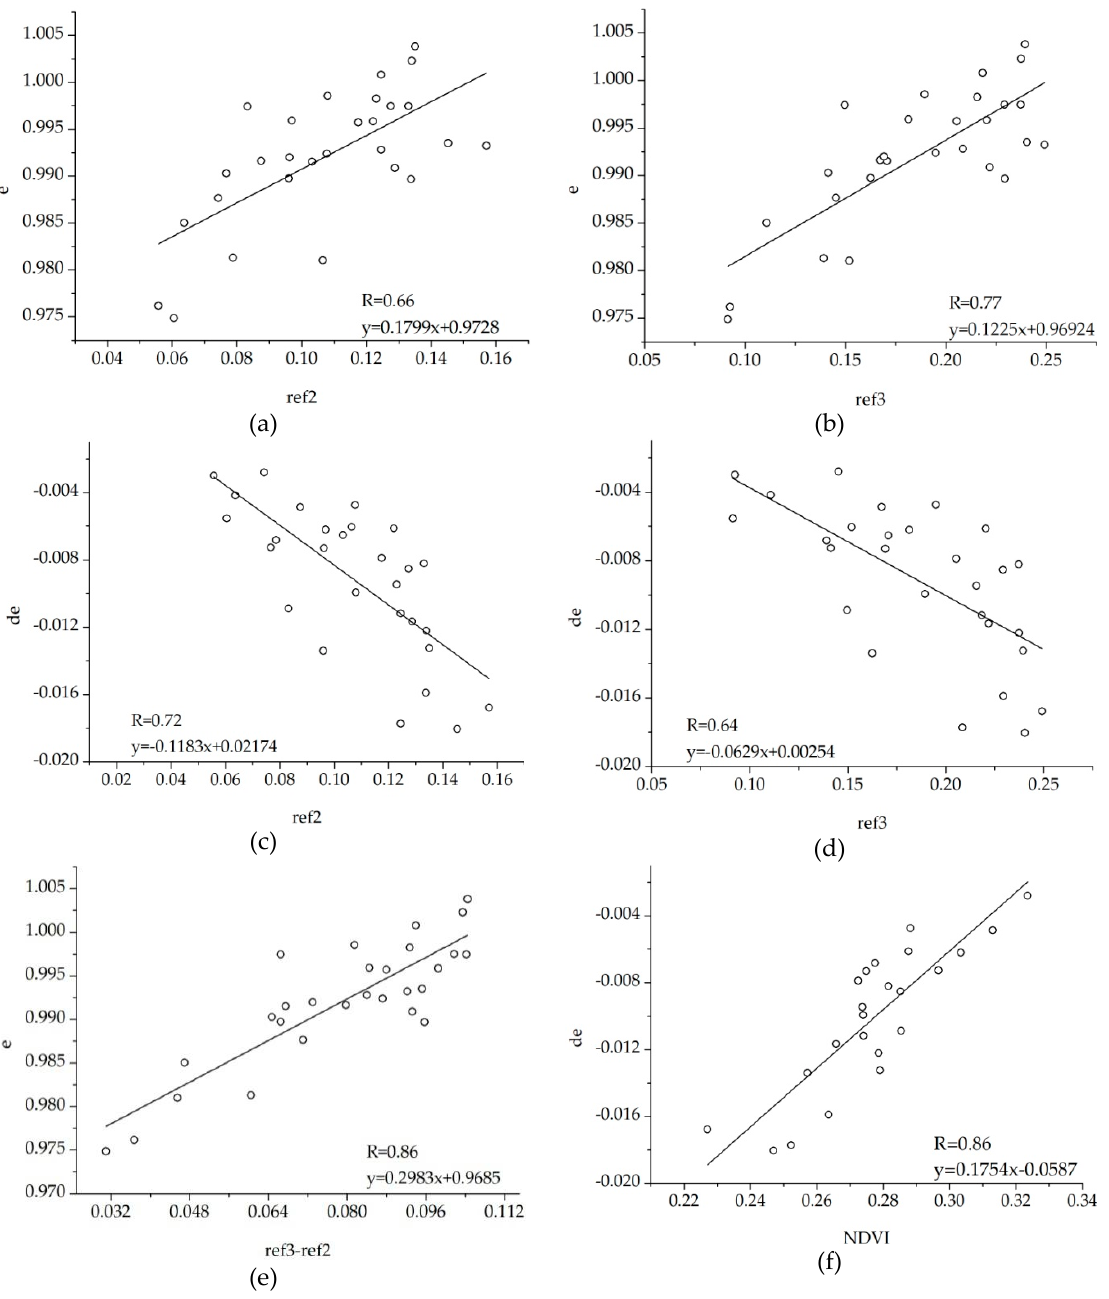
Figure 5. Correlation analysis between average channel emissivity and channel reflectance and its combined parameters, where ( a ) is the correlation analysis between e and ref2, ( b ) is the correlation analysis between e and ref3, ( c ) is the correlation analysis between de and ref2, ( d ) is the correlation analysis between de and ref3, ( e ) is the correlation analysis between e and “ref3–ref2” , and ( f ) is the correlation analysis between de and normalized vegetation index